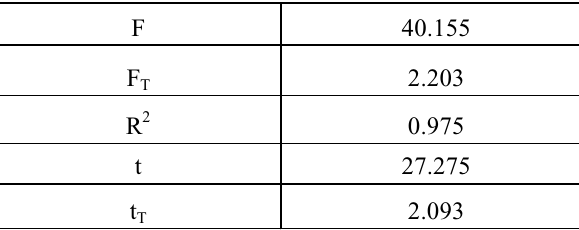
Table 7 . Statistics of multiple linear regression